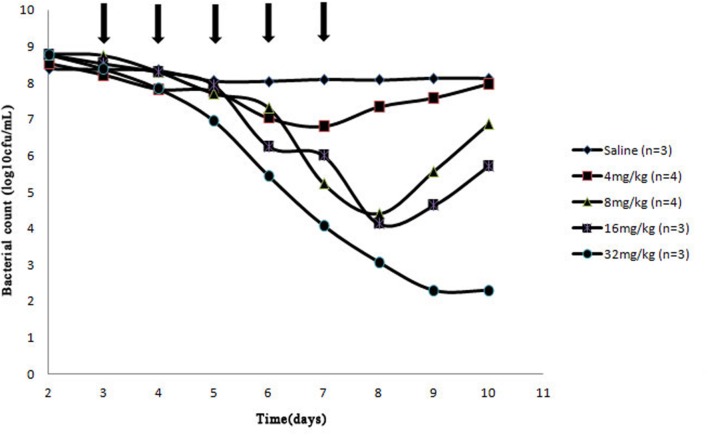
Effect of cefquinome at different doses on bacterial survival in the tissue-cage model (24 h intervals). Three days after infection, different doses (0, 4, 8, 16, and 32 mg/kg of body weight by use of intragluteal injection) of cefquinome were administered once daily for 5 days (indicated by the arrow). n is the animal number per group.